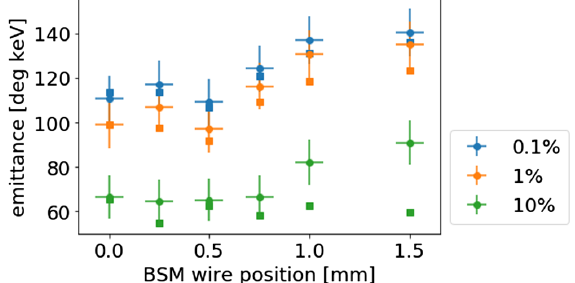
FIG. 13. Dependence of longitudinal emittance on position of BSM wire. The rms emittance is calculated for three threshold ˆ f ð ϕ ; w Þj levels for both the 1D slice ˜ y 2 (shown with error bars) as ˆ f ð ϕ ; w Þj well as 3D slice ˜ x; ˜ x 0 ; ˜ y 2 (square points without error bars) at fixed location ˜ x; ˜ x 0 ∼ 0 , y 2 ∝ BSM wire.